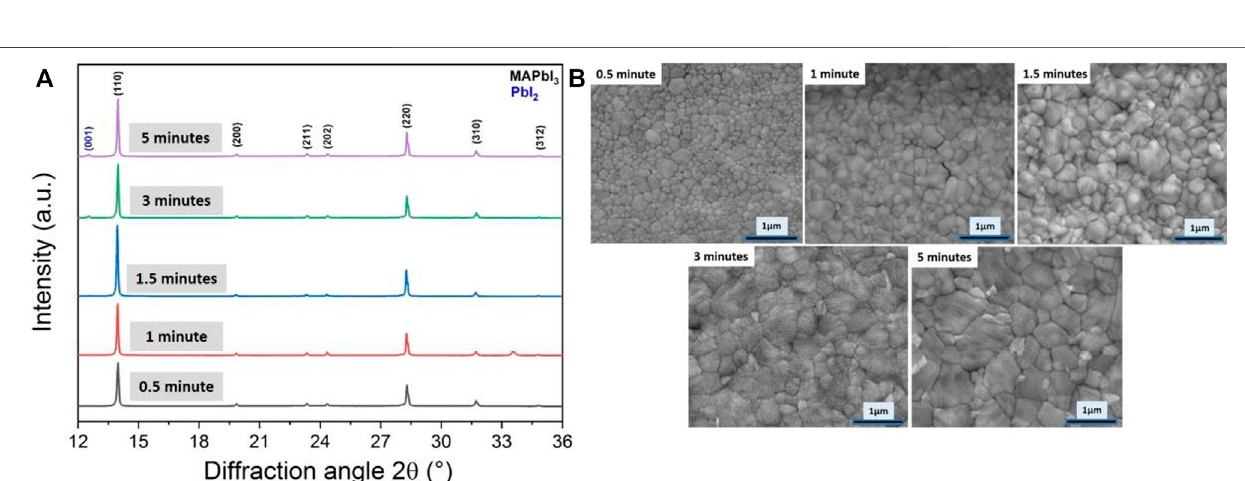
Frontiers in Energy Research |